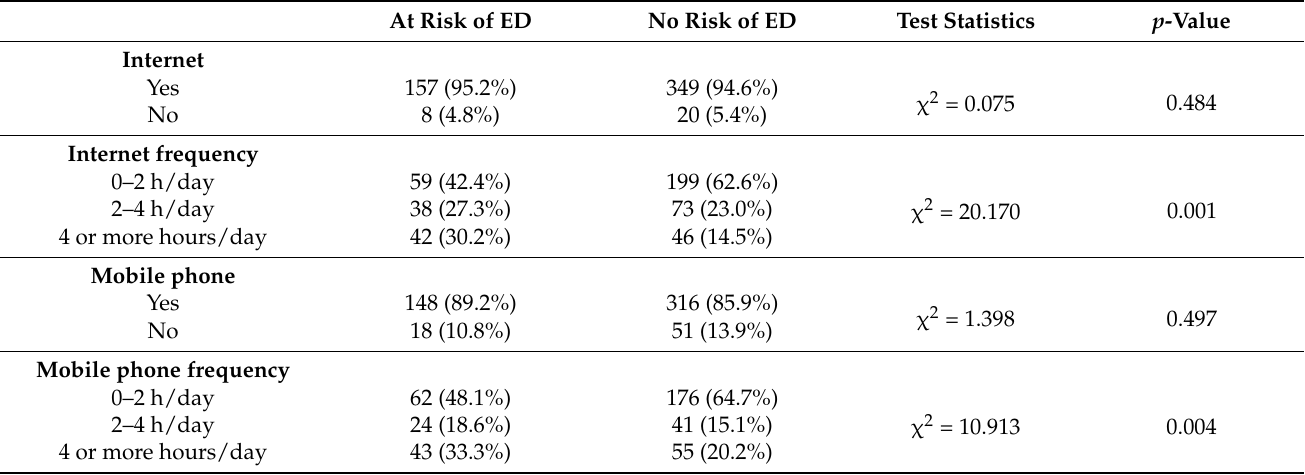
Table 4. Distribution of variables related to new technologies and media use measures according to eating disorder